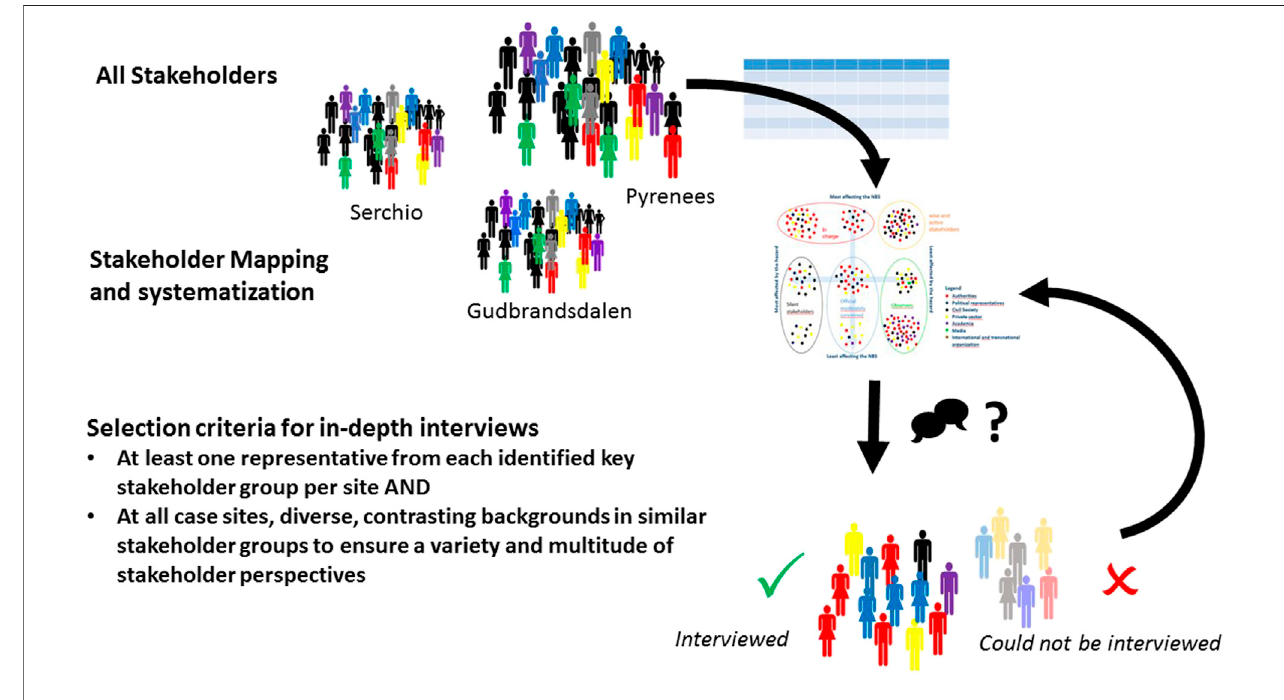
FIGURE 3 | Selection process of